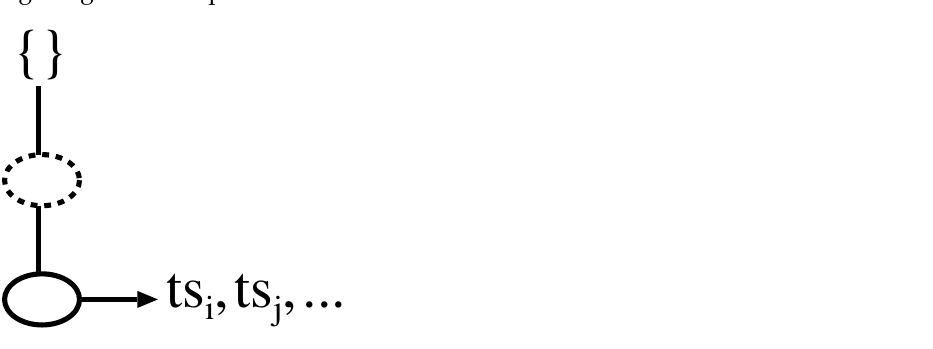
Figure 1. Conceptual structure of the prefix tree in a 3P-tree. Dotted ellipses represent ordinary nodes, while the other ellipses represent the tail nodes of the sorted transactions with time stamps of ts i and ts j ∈ R